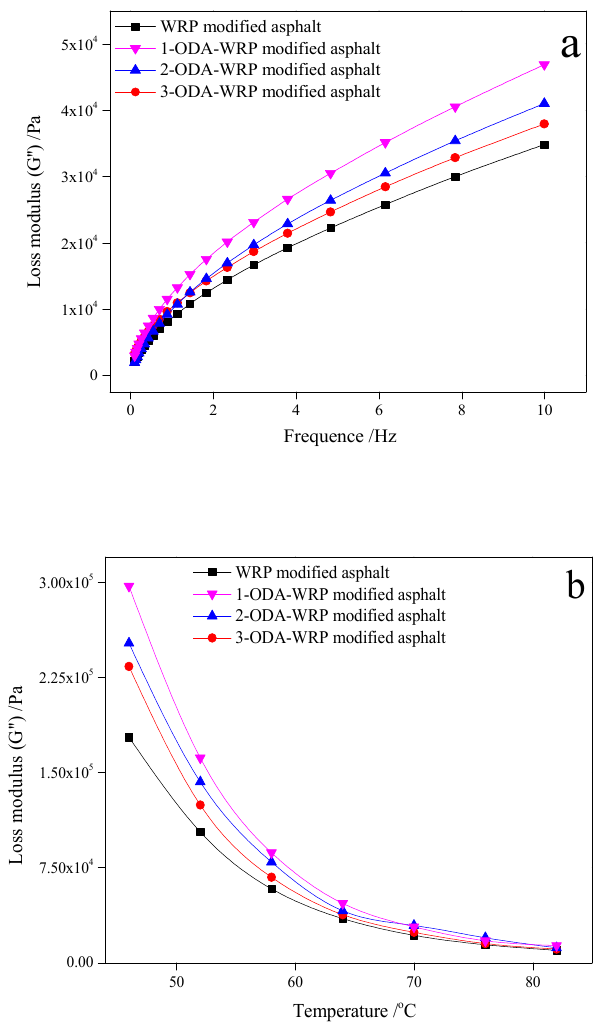
Figure 6. Variation in G” with: ( a ) frequency at 64 ◦ C and ( b ) temperature at 10 Hz for di ff erent kinds of ODA-WRP.